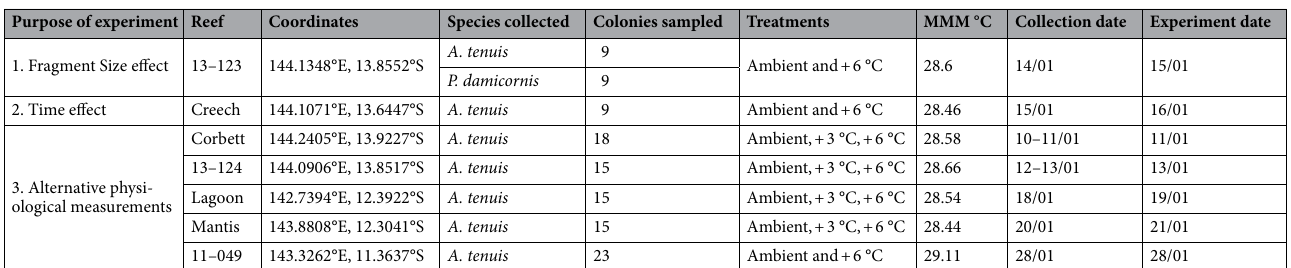
Table 3. Coral collection and experiment details. Collection dates are given as day of January